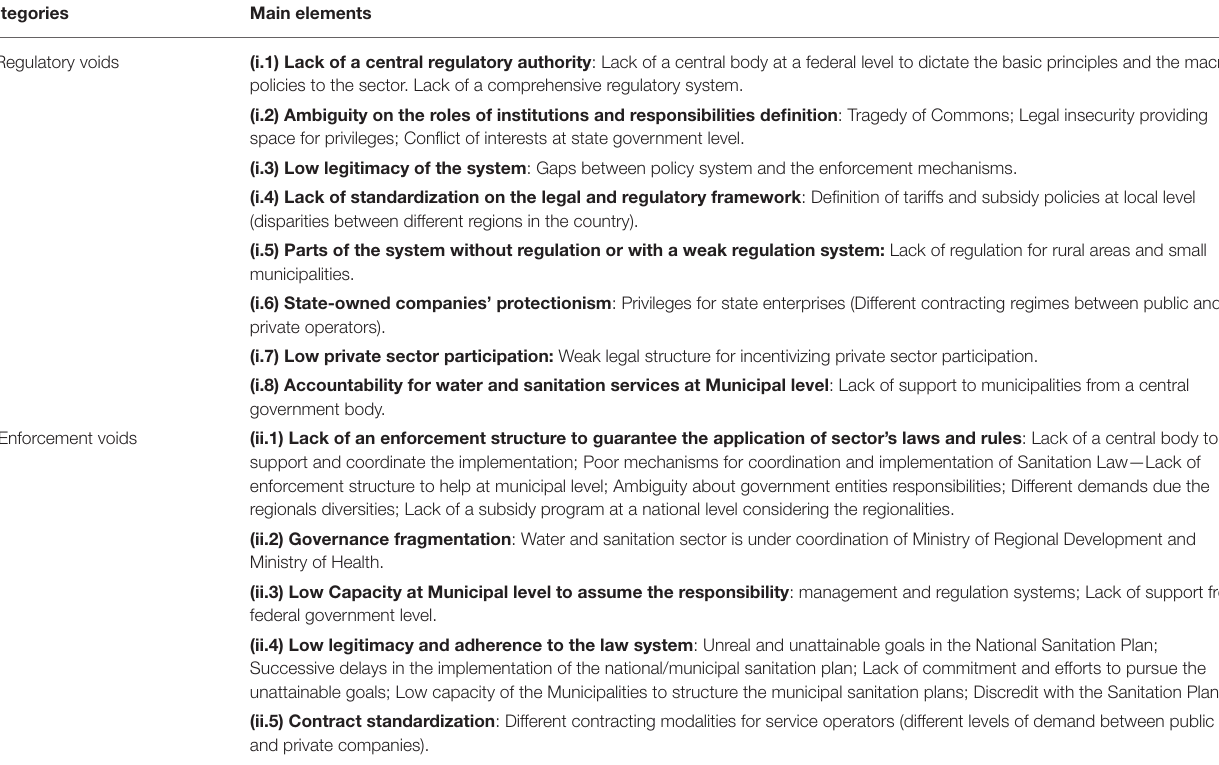
TABLE 4 | Institutional constraints—institutional voids in the governance and regulatory system: categories and main elements.